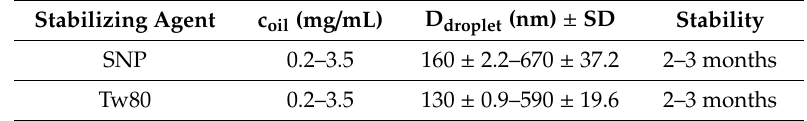
Table 1. Stability parameters and droplet sizes of Pickering nanoemulsion and conventional